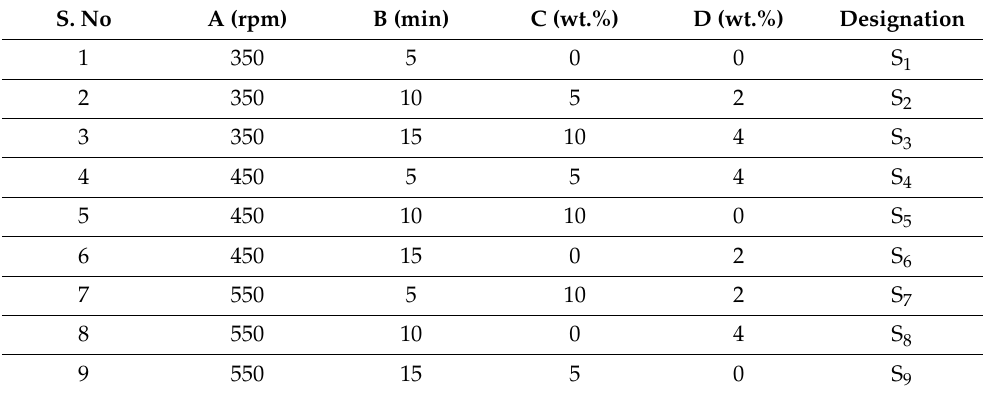
Table 4. Experimental design for composite